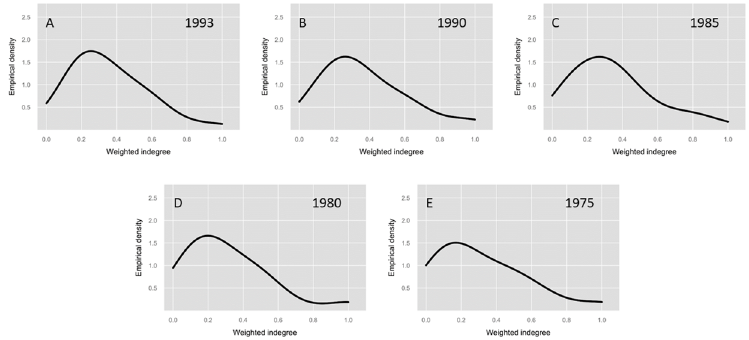
Fig 3. Density first-order weighted indegree input-output matrices1975–1993. (A) Matrix 1993, 34 economicsectors. (B) Matrix 1990, 34 economicsectors. (C) Matrix 1985, 34 economicsectors. (D) Matrix 1980, 34 economicsectors. (E) Matrix 1975, 34 economicsectors.